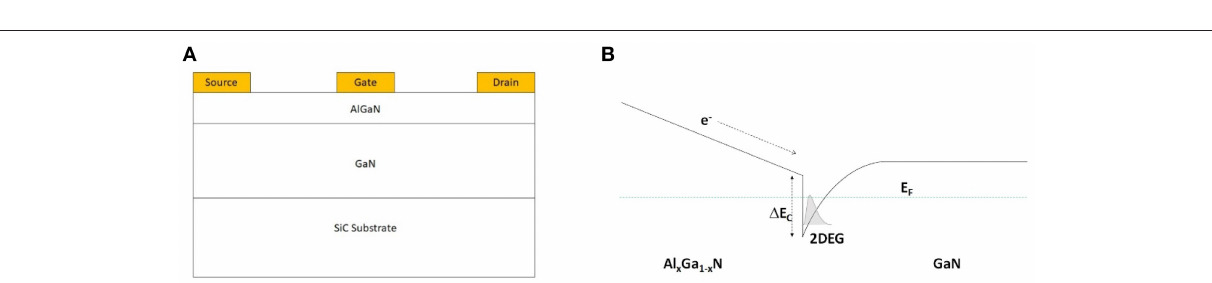
measured the output power, small-signal gain and harmonic content of the HEMT output. The RF input with amplitude of about 0 dBm (1 mW) was generated by a low-noise continuous- wave (CW) network analyzer followed by an RF switch to